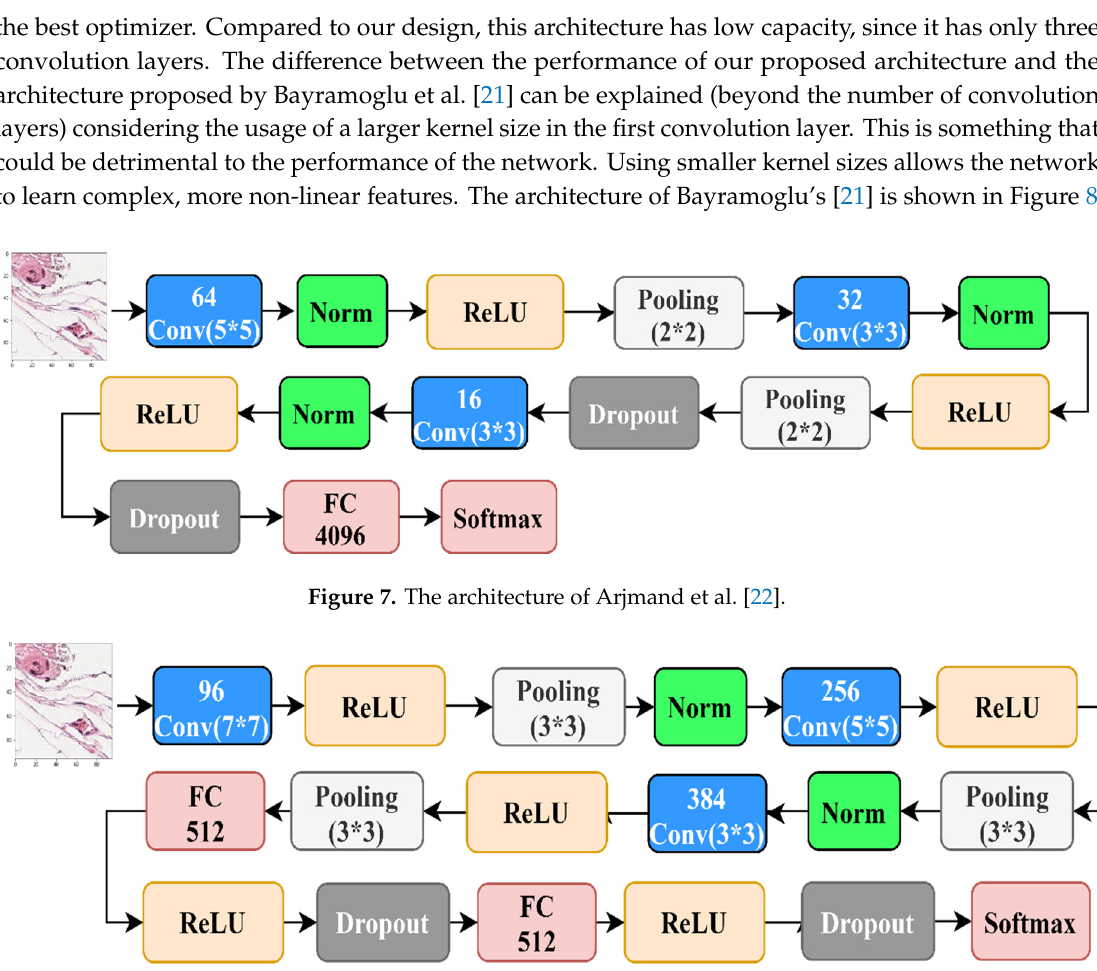
Figure 5. The architecture of Lai et al. [24].